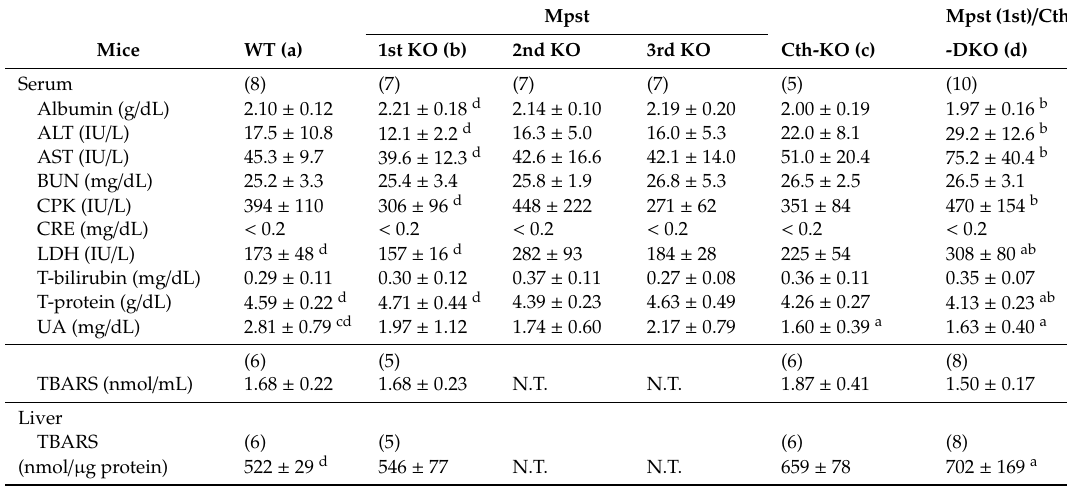
Table 3. Biochemical parameters in serum (and liver only for TBARS activity) for adult wild-type, Mpst (1st–3rd)-KO, Cth-KO, and Mpst (1st) / Cth-DKO mice. Mpst Mpst (1st) / Cth Mice WT